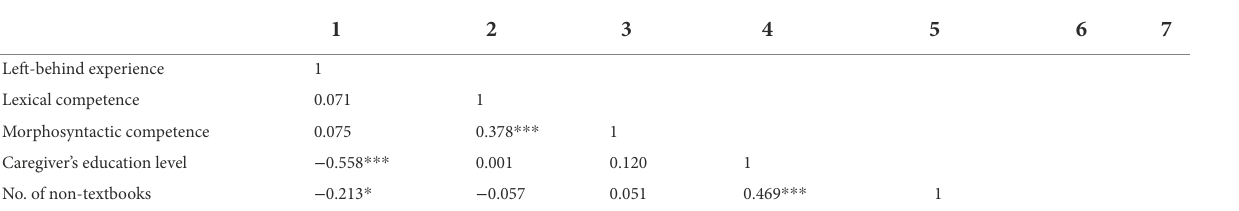
TABLE 2 Summary of intercorrelations between predictors.